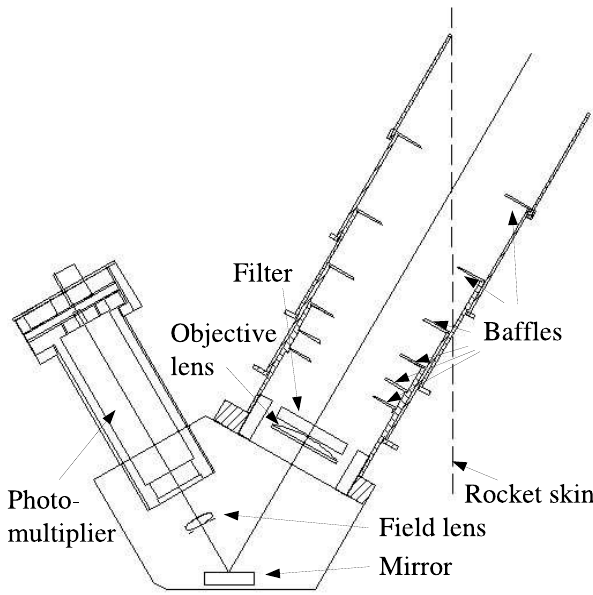
Fig. 1. Design of the ECOMA photometer. Important new features are the compact bent geometry and the extendable baffle